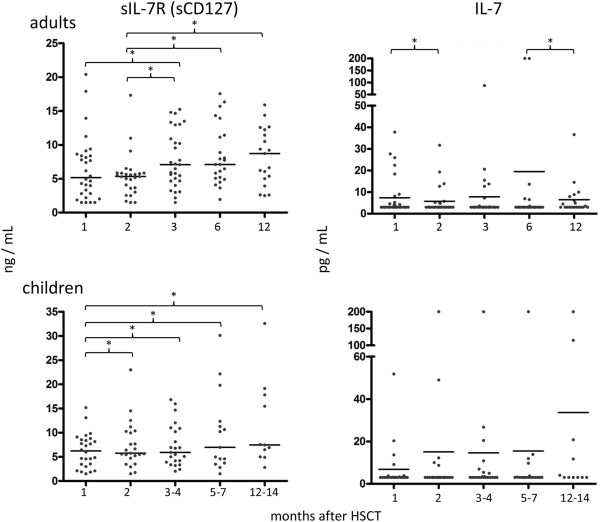
Levels of soluble Il-7R (sCD127, left figures) and IL-7 (right figures) in plasma from adults and children after HSCT. * = p < 0.05. Plasma was obtained at different time points after HSCT and examined for IL-7 and sIL-7R by ELISA. Median levels are marked with a bar. sIL-7R levels increased with time after HSCT (non-parametric Wilcoxon test). Differences in plasma from children: 2 months after aHSCT as compared to 1 month (p = 0.02), 3–4 months vs. 1 month (p = 0.04), 5–7 months vs. 1 month (p = 0.02) and 12–14 months vs. 1 month (p = 0.03).